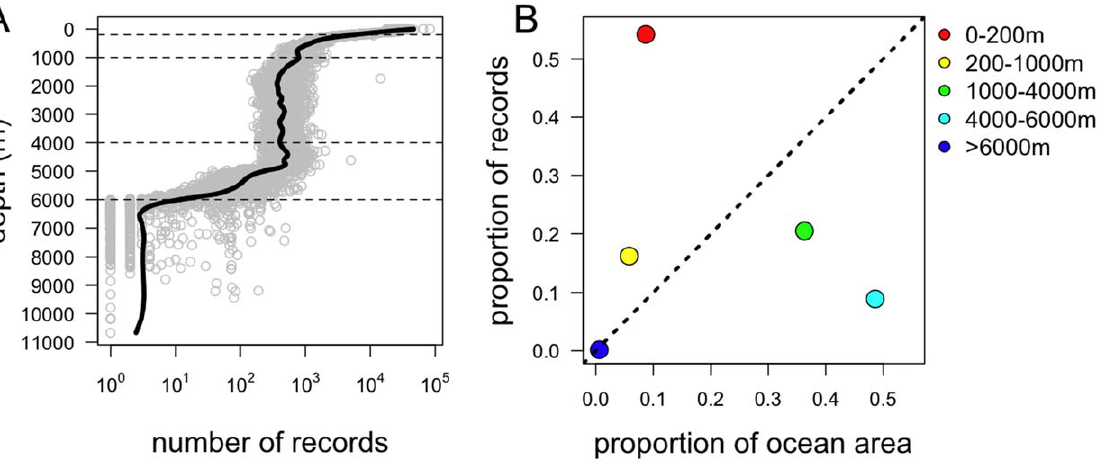
Figure 1. The depth distribution of OBIS records of global marine biodiversity. A. Number of OBIS records against ocean depth (grey symbols); the general trend is illustrated with a lowess smooth (solid line). Horizontal dashed lines indicate the divisions into regions A-E defined by depth at 200, 1000, 4000 and 6000m (see Table 1). B. The proportion of all OBIS records occurring in the different depth zones identified in Table 1, against the proportion of the global ocean that occurs at those depths. The 1:1 line identifies those areas of the ocean with proportionately more (points above the line) or fewer (points below the line) records than expected given their area. This gives a conservative view of under- and over- representation based on the volume of each habitat.